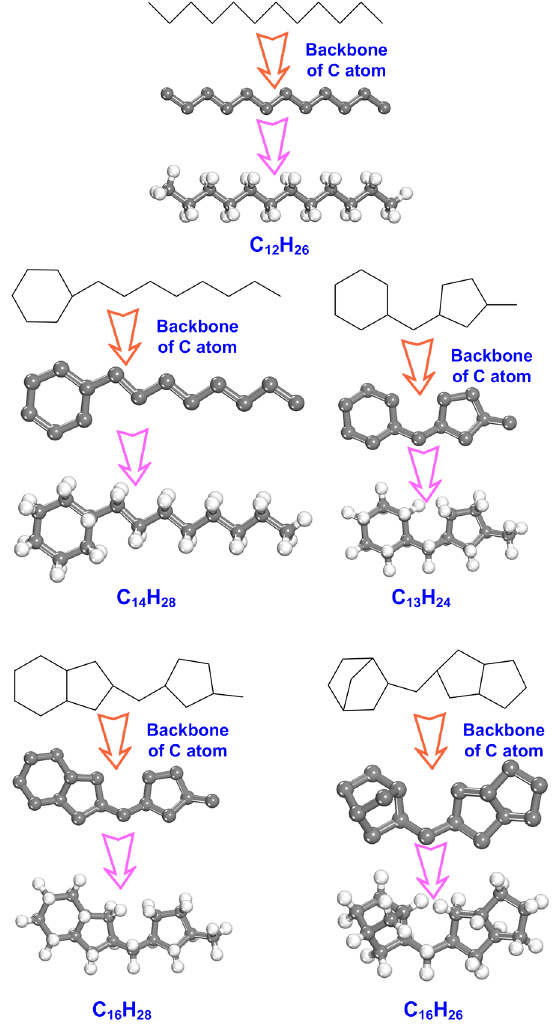
Figure 1. Main components of naphthenic mineral insulating oil.